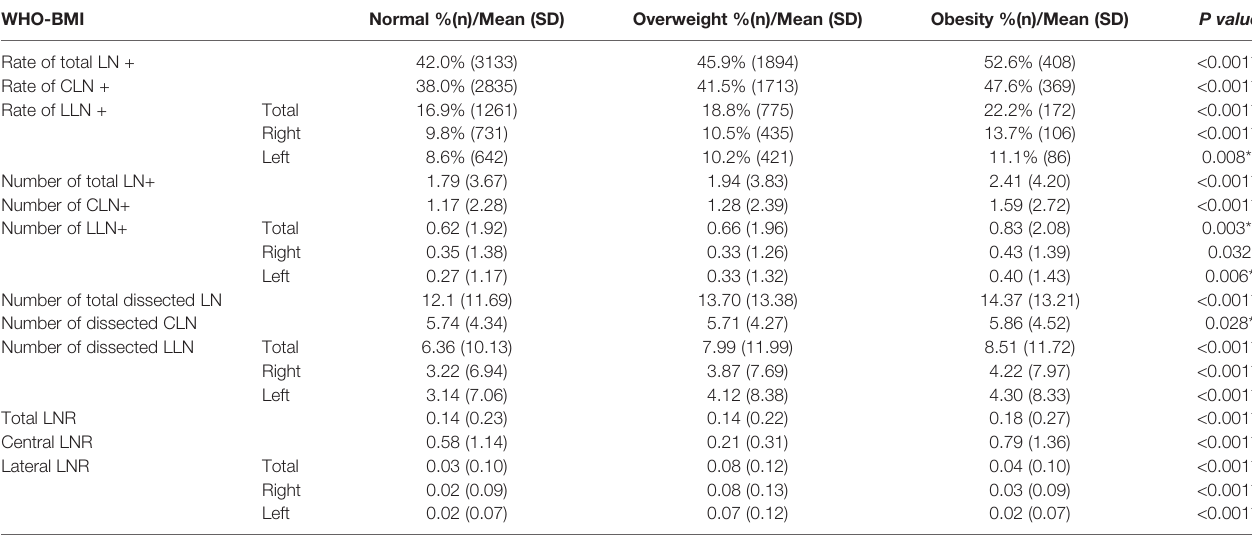
TABLE 3 | Relationship between obesity and different regional patterns of lymph node involvement.